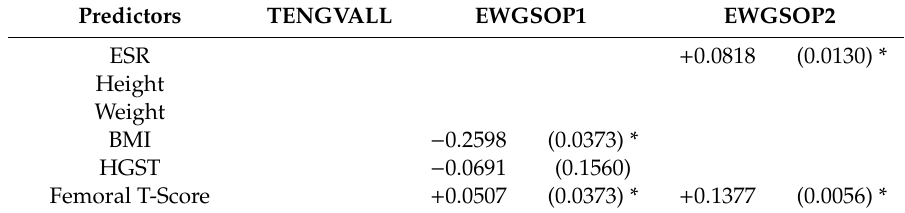
Table 5. The results of logistic regression for risk factors associated with low ASMI among